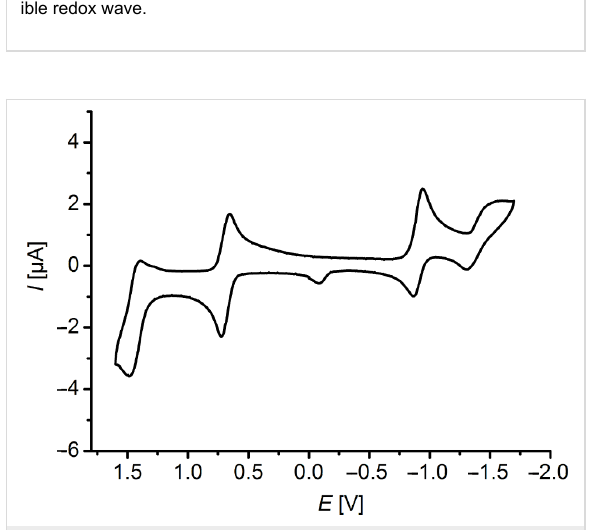
Figure 3: Cyclic voltammogram of dyad 8c (recorded in CH 2 Cl 2 , T = 298 K, c ( 8c ) = 0.1 mol·L − 1 , Pt working electrode, Pt counter electrode, Ag/AgCl reference electrode, electrolyte N( n -Bu) 4 PF 6 , scan rate of 250 mV·s − 1 ).